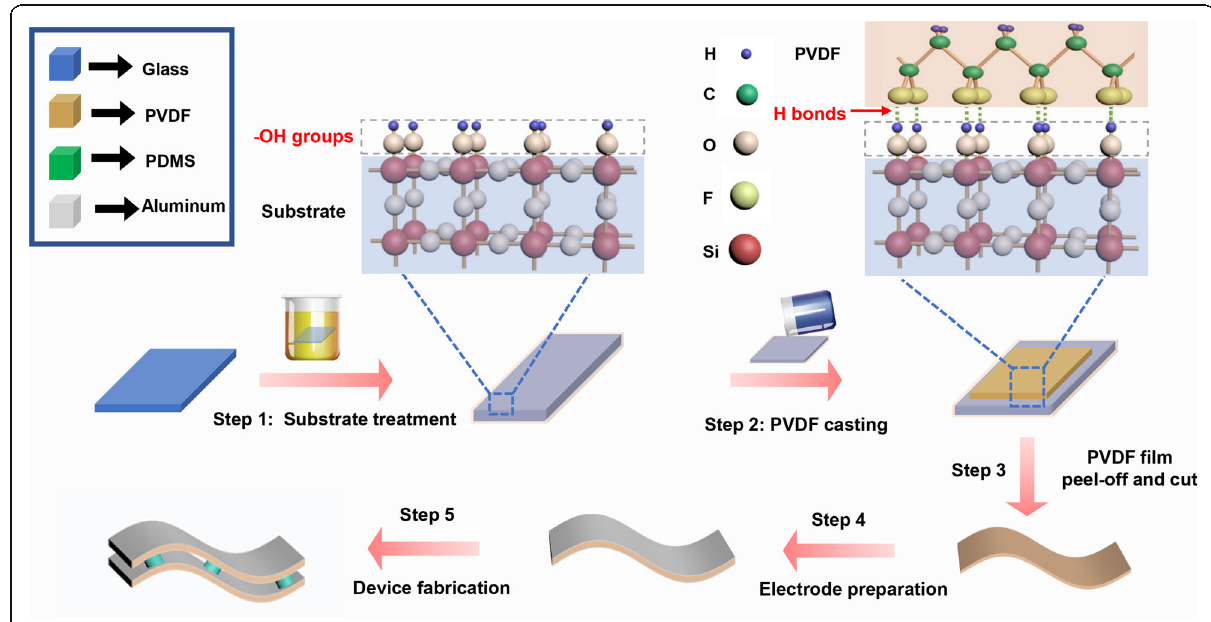
Fig. 1 Illustration of PVDF film and device preparation process. Step 1, the glass substrate was soaked in piranha solution for 2 – 8 h. Step 2, well- stirred PVDF solution was cast on the substrate and dried at 80 °C for 10 h. Step 3, the PVDF film was peeled off from the substrate, and the edge was cut off to remove edge effect. Step 4, aluminum was evaporated onto both sides of the film as electrodes. Step 5, the bilayer device was fabricated by using PDMS pillars supported between the two layers as separators. Also indicated were schematics of the hydroxyl groups bonded on the surface of the glass substrate after treatment, hydrogen bonds formation after PVDF casting and orderly arrangement of the “ ultra-thin layer ” at the bottom of PVDF